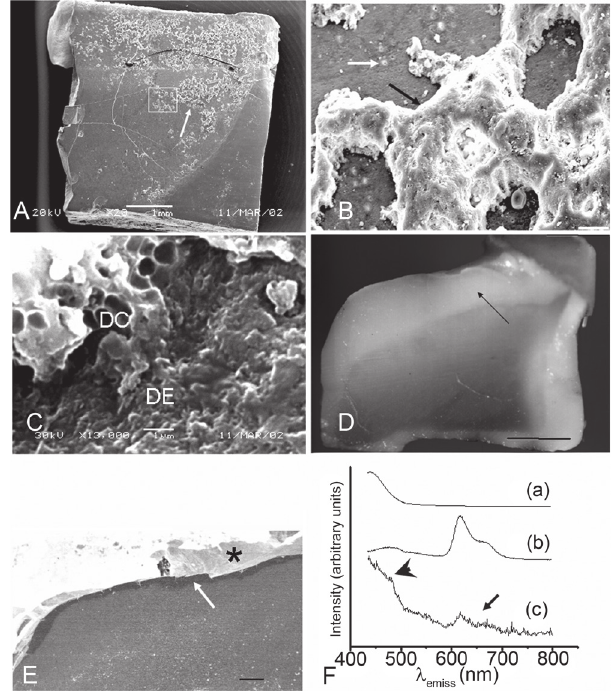
Figure 1. A , calculus deposits (arrow), of macroscopic size, on a 9-day sample with demineralization (Bar = 1 mm). B , detail of the area outlined in “A”, showing opening of dentinal tubules (white arrow) and dental calculus (black arrow) (Bar = 20 mm). C , detail of the area close to the white arrow in “B”, showing mineralized bacterial outlines delimitating spaces of ~ 1 mm in diameter (DC, dental calculus) and the demineralized dentin (DE) (Bar = 1 mm). D , histological aspect of the same sample after hemi-sectioning showing demineralization (black arrow) below the experimental surface (Bar = 1 mm). Opaque outline is demineralization caused by bacterial acid infiltrated around the sample. E , BSE-SEM image (bar = 300 mm) showing, below the fractured surface (asterisk), a dark layer (white arrow) representing the preserved part of the demineralised area indicated by the black arrow in “D”. F , fluorescence spectroscopy data of different samples dissolved in HCl 27% and excited with light at 416 nm: (a), human dentin; (b), human dental calculus; and (c), sample from the surface of the sample shown in “A”, showing fluorescence of dentin (arrowhead) and dental calculus